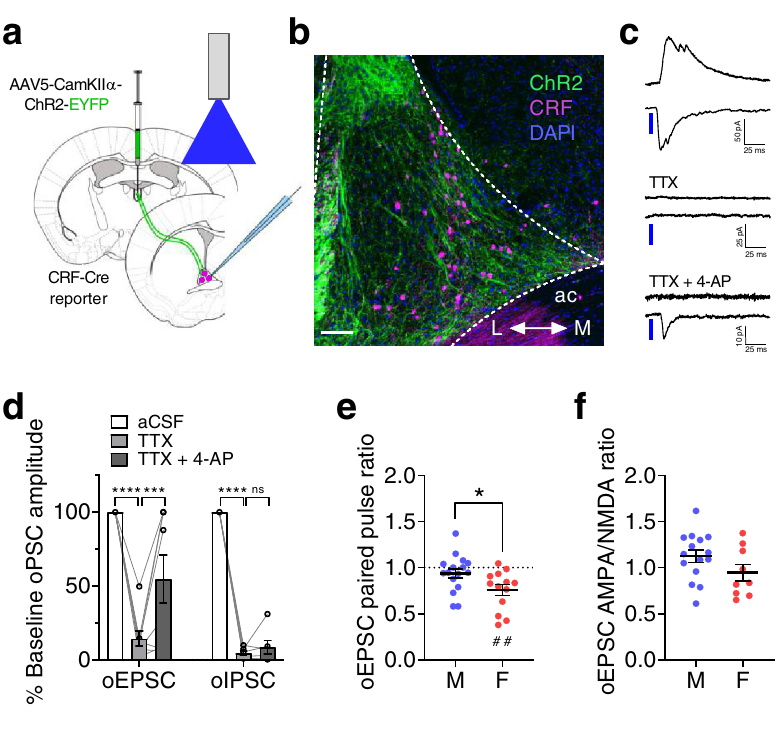
Fig. 3 The PVT-BNST projection provides polysynaptic inhibition onto BNST CRF neurons. a – b Approach for slice recordings in BNST CRF neurons during optical excitation of ChR2 in PVT axon terminals ( a ) and representative coronal image of the dorsal BNST ( b ); ac = anterior commissure, L = lateral, M = medial. Scale bar = 100 μ M. Similar images were used to visually con fi rm ChR2 expression in each round of surgery and produced similar results. c – d Representative traces ( c ) and quanti fi cation ( d ) of time-locked optically-evoked EPSCs (oEPSCs) and IPSCs (oIPSCs) in BNST CRF neurons in response to 2 ms pulses of blue LED at baseline, in the presence of tetrodotoxin (TTX, 1 μ M), and with the addition of 4-aminopyridine (4-AP, 100 μ M). oEPSCs: 1xRM- ANOVA effect of drug ( F 2,14 = 22.6, P < 0.0001), post hoc two-tailed paired t -tests with Holm-Sidak corrections (aCSF vs. TTX: t 14 = 6.71, **** P < 0.0001; TTX vs. TTX + 4-AP: t 14 = 3.16, ** P = 0.007); N = 5 mice, 8 cells. oIPSCs: 1xRM-ANOVA effect of the drug (F 2,10 = 429.0, P < 0.0001), post hoc two-tailed paired t -tests with Holm-Sidak corrections (aCSF vs. TTX: t 10 = 25.90, **** P < 0.0001; TTX vs. TTX + 4-AP: t 10 = 1.10, P = 0.299); N = 4 mice, 6 cells. e Paired pulse ratio of pharmacologically-isolated oEPSCs is lower in females than males (two-tailed unpaired t -test: t 27 = 2.33, * P = 0.028) and below 1 in females (one-sample t -test: t 12 = 4.07, ## P = 0.002) but not males (one-sample t -test : t 15 = 2.33, P = 0.235). N ’ s = 4 M, 16 cells; 3 F, 13 cells. f oEPSC AMPA/NMDA ratios between sexes (two - tailed unpaired t -test: t 22 = 1.61, P = 0.121). N ’ s = 4 M, 15 cells; 3 F, 9 cells. Data are presented as mean values ±